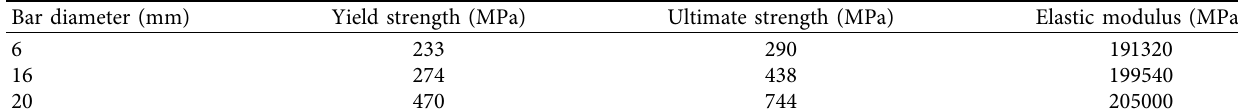
Table 2: Specifications of steel reinforcement.